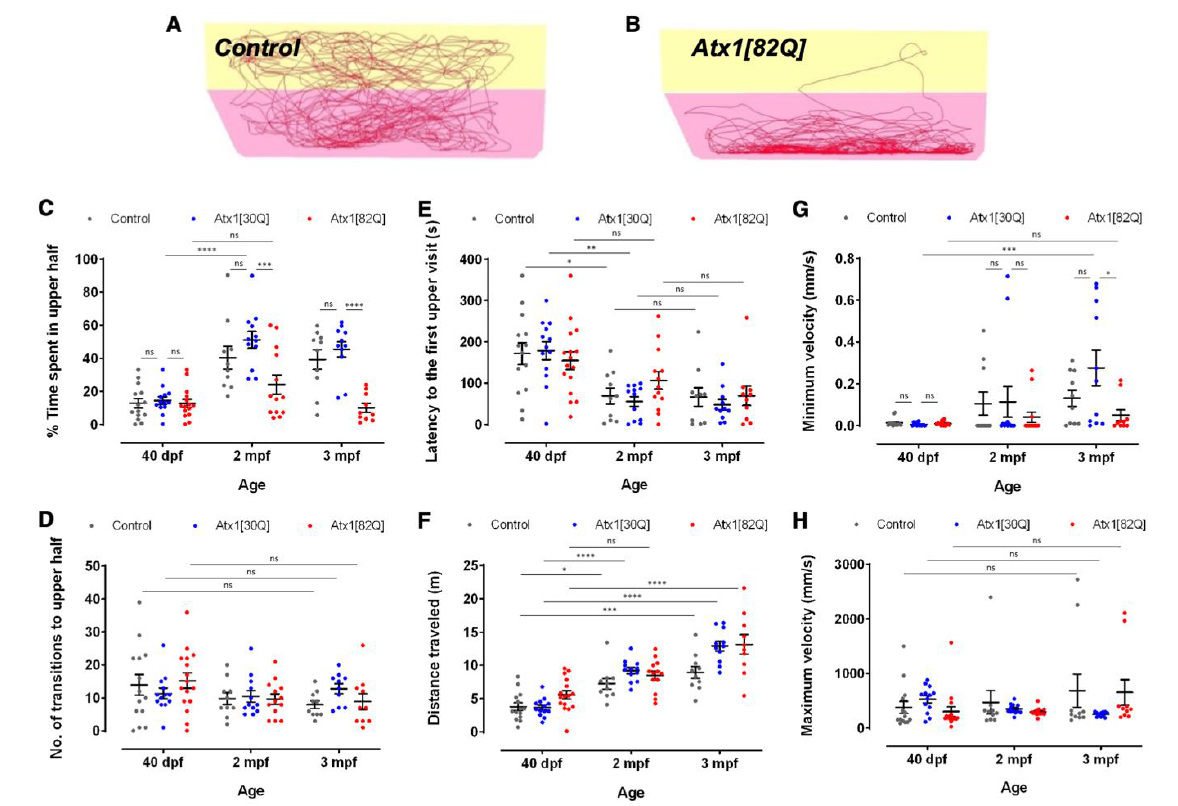
Figure 5. Age-dependent exploratory behavioural comparison of control and hAtx1 expressing zebrafish. Novel tank diving tests were performed with GAPmScarlet, Atx1[30Q], and Atx1[82Q] larvae at 40 dpf, juveniles at two months and young adults at three months of age, respectively. Examples of 6-min traces for ( A ) a GAPmScarlet control fish and ( B ) an Atx1[82Q] carrier are shown, the bottom half of the tank is marked in pink, the upper half in yellow. ( C ) Percentage of time spent in the upper half of the novel tank during a 6-min observation period. ( D ) Number of entries into upper tank half during the entire observation period. ( E ) Latency until upper tank half is entered for the first time. ( F ) Total distance travelled during the entire observation period. ( G ) Minimal and ( H ) maximal velocity of swim movements measured during the observation period. Data are presented as mean ± SEM, * p < 0.05, ** p < 0.01, *** p < 0.001 and **** p < 0.0001 (according to two-way ANOVA with post hoc Tukey’s test). n = 14,10,10 in 40 dpf, 2 mpf, and 3 mpf control groups; n = 13,12,11 in 40 dpf, 2 mpf and 3 mpf Atx1[30Q] groups; and n = 15,13,10 in 40 dpf, 2 mpf, and 3 mpf Atx1[82Q] groups, respectively.